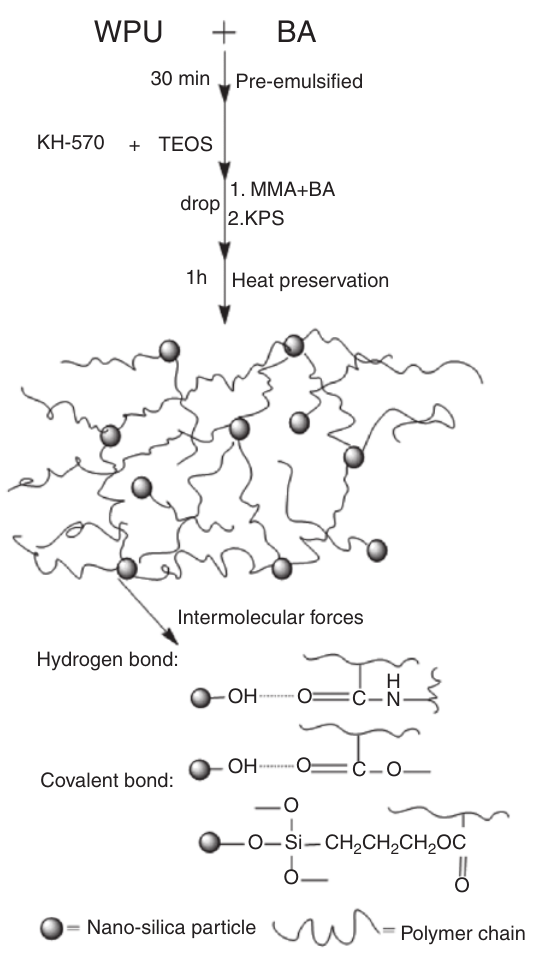
Figure 2: Schematic diagram of the synthesis of SPUA composite